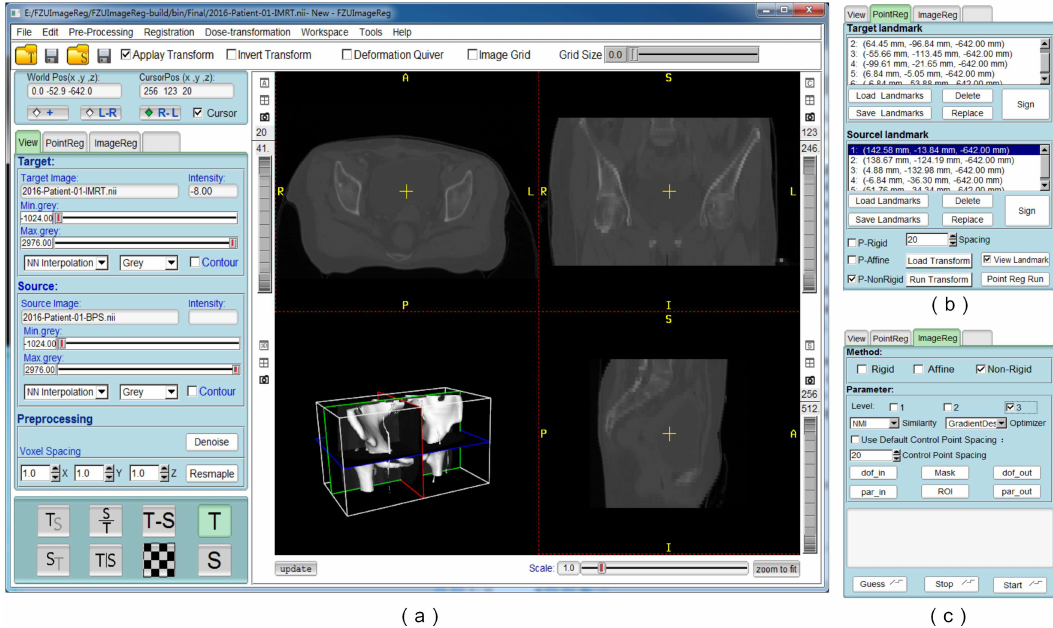
Fig 6. Screenshot of the proposed FZUImageReg system. (a) Main windowinterfaces of FZUImageReg (b) Point set registrationpanel (PointReg). (c) Automatic image registration panel (ImageReg).